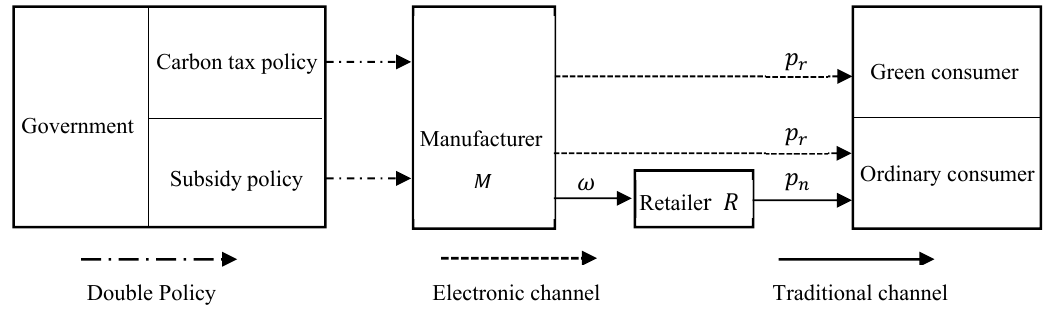
Figure 1. The dual-channel supply chain structure. Figure 1. The dual ‐ channel supply chain structure.